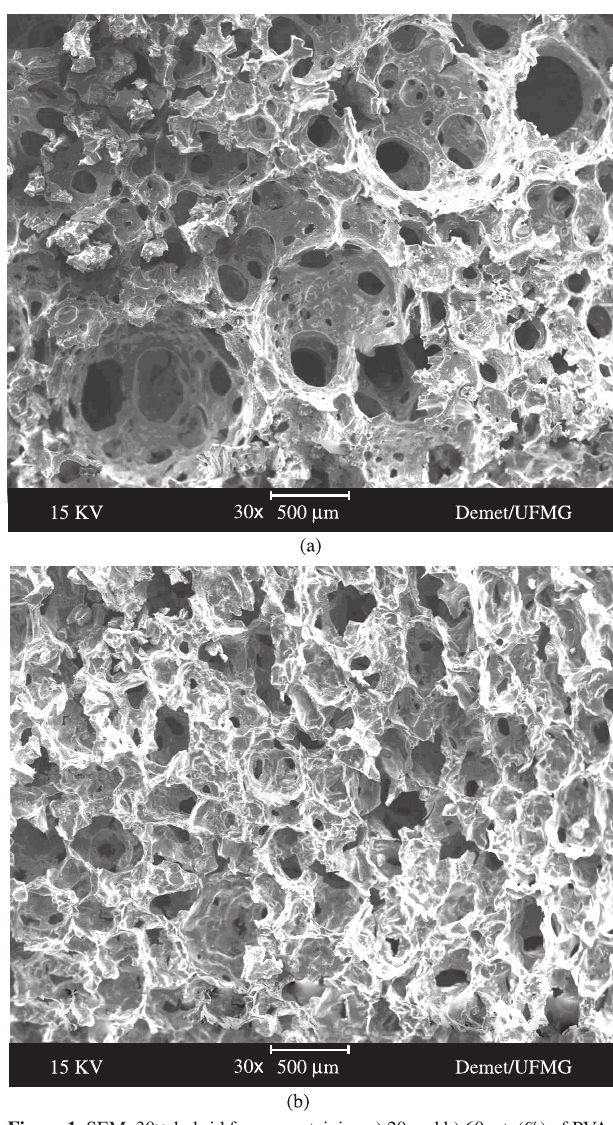
Figure 1. SEM, 30 x , hybrid foams containing a) 20 and b) 60 wt. (%) of